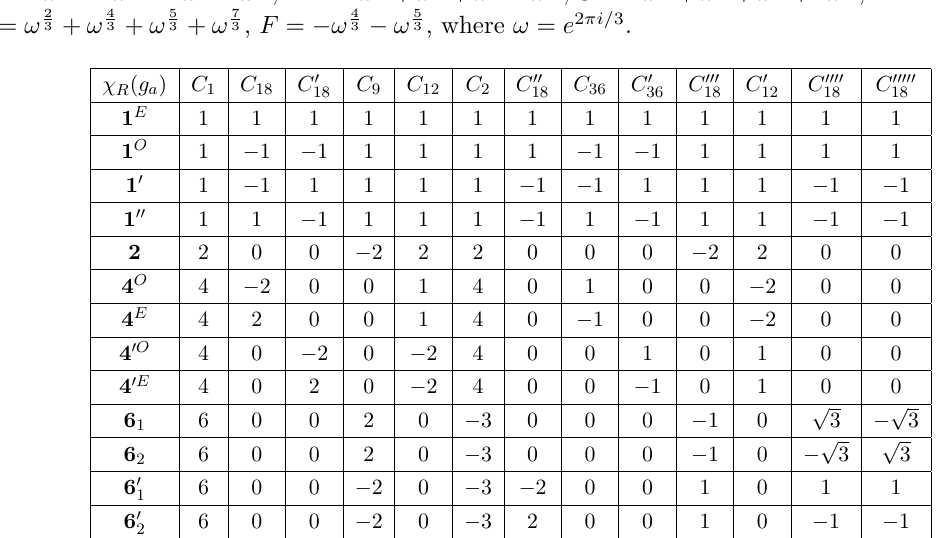
Table 5 . Character table for G o S 3 . The subscripts of the conjugacy classes indicate their size, and A = (cid:0) ! 2 3 (cid:0) 2 ! 4 3 (cid:0) 2 ! 5 3 (cid:0) ! 7 3 , B = (cid:0) ! 2 3 + ! 4 3 + ! 5 3 (cid:0) ! 7 3 , C = 2 ! 2 3 + ! 4 3 + ! 5 3 +2 ! 7 3 , D = (cid:0) ! 2 3 (cid:0) ! 7 3 ,